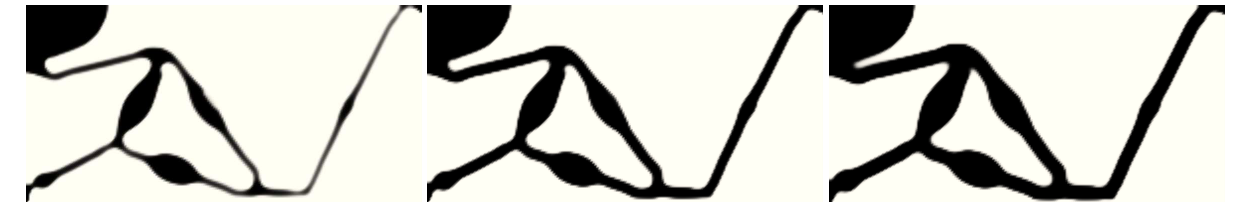
Figure 4. Three threshold projections, eroded, intermediate and dilated, obtained with thresholds η = 0 . 6 , 0 . 5 and η = 0 . 4, respectively. The design is obtained using large displacements robust optimisation formulation with threshold η ∈ U [0 . 3 , 0 . 7] and volume constraint 30% of the original volume imposed on the dilated projection at η = 0 . 3. The objective is E[ c ] = − 7 . 85 µ m, the standard deviation is STD[ c ] = 1 . 0, the number of the integration points is 2, and the projection parameter is β = 32. The objective expectation and standard deviation, computed with 31 integration points Kronrod-Patterson rile are E[ c ] = − 8 . 43 and STD[ c ] = 5 . 83.